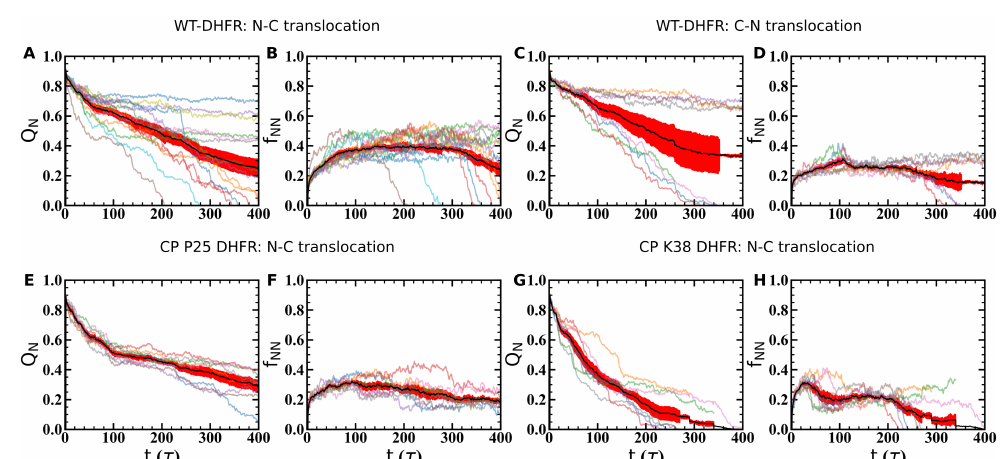
Figure 5. Unfolding of DHFR variants mediated by ClpY. The time evolution of the fraction of native, Q N , and non-native, f NN , contacts is shown for wild-type DHFR in ( A , B ) N-C and ( C , D ) C-N translocation; ( E , F ) for CP P25 and ( G , H ) for CP K38 in N-C translocation. Individual trajectories are indicated by using thin curves. Averages (thick curves, black) and standard errors (red) are also